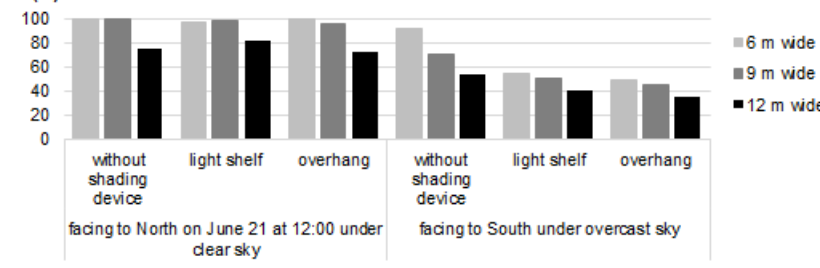
Fig. 5. Percentage of the DA of 6 m, 9 m, and 12 m wide rooms with 3 variations in fenestration model on the first floor in an urban area with h / w = 4 and le / L =